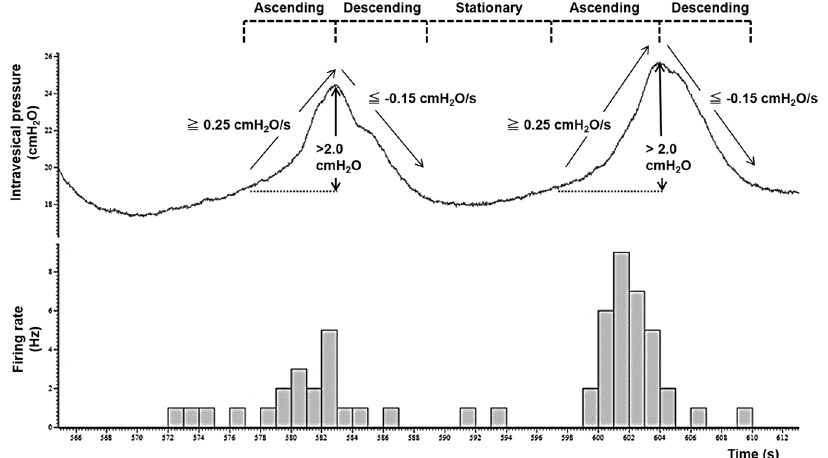
Figure 5. Definition of the microcontractions (ascending and descending phases) and stationary phase in the present study. Upper trace is intravesical pressure, and lower trace is firing rate of SAAs. The microcontractions were defined as the contractions having more than 2 cmH 2 O of amplitude, and pressure was ascending at 0.25 cmH 2 O/s or more, and then descending at 0.15 cmH 2 O/s or more. And the portions between these phases were defined as the stationary